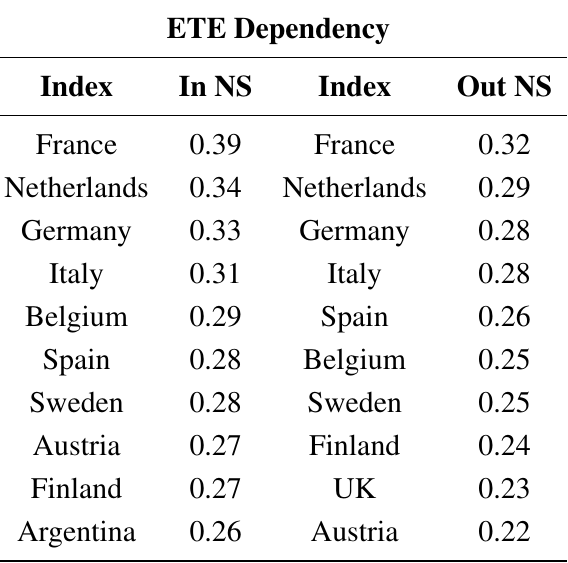
Table 2. Top ten indices according to In and Out Node Strengths based on ETE